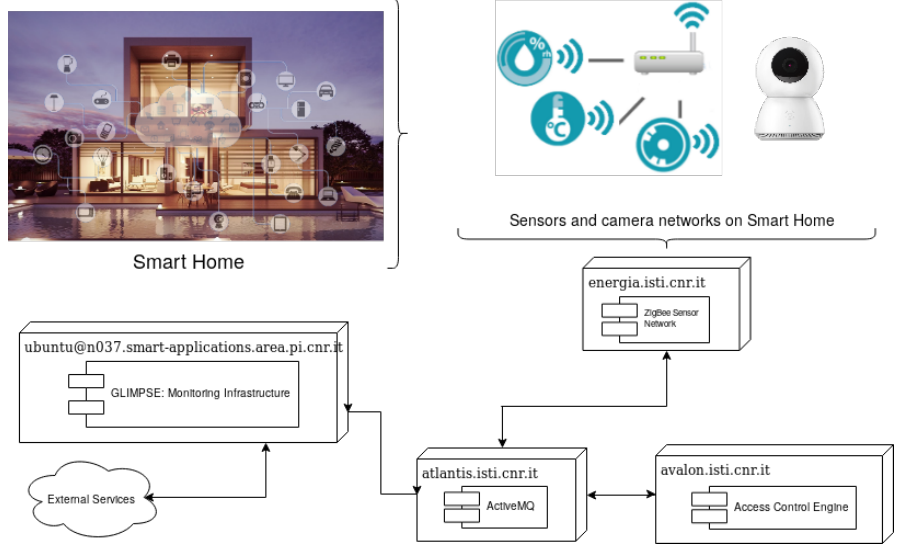
Figure 6. Deployment